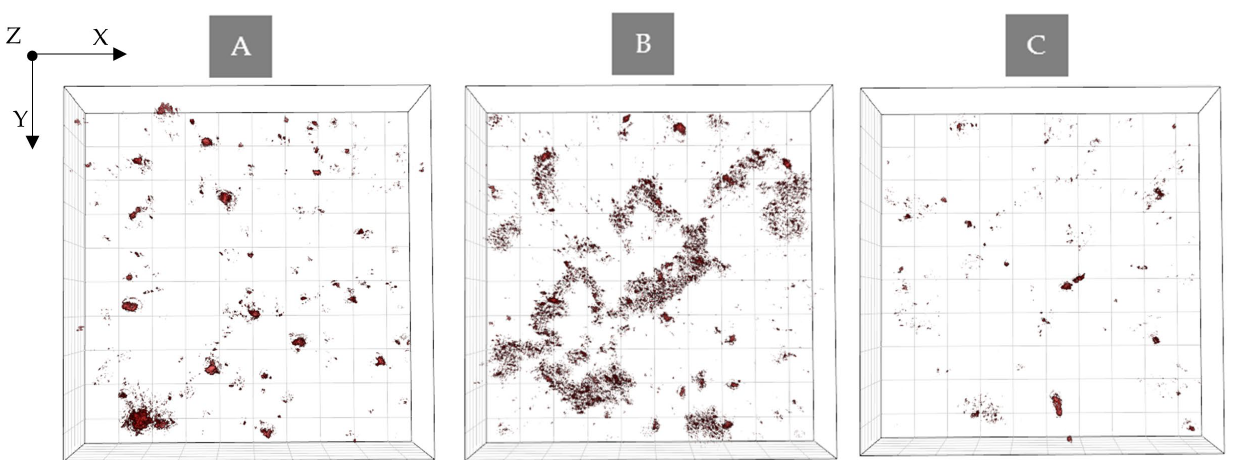
Figure 8. Digitally stained (based on the RI values) photosensitizer aggregates ( A ) Ce6 + Pheo, ( B ) Ce6, and ( C ) Pheo after 48 h incubation with PS.